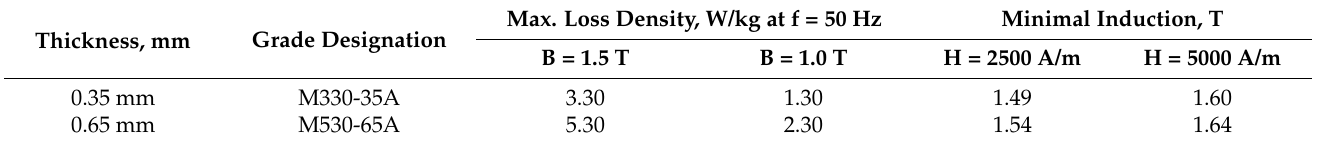
Table 2. Basic properties of the examined steel